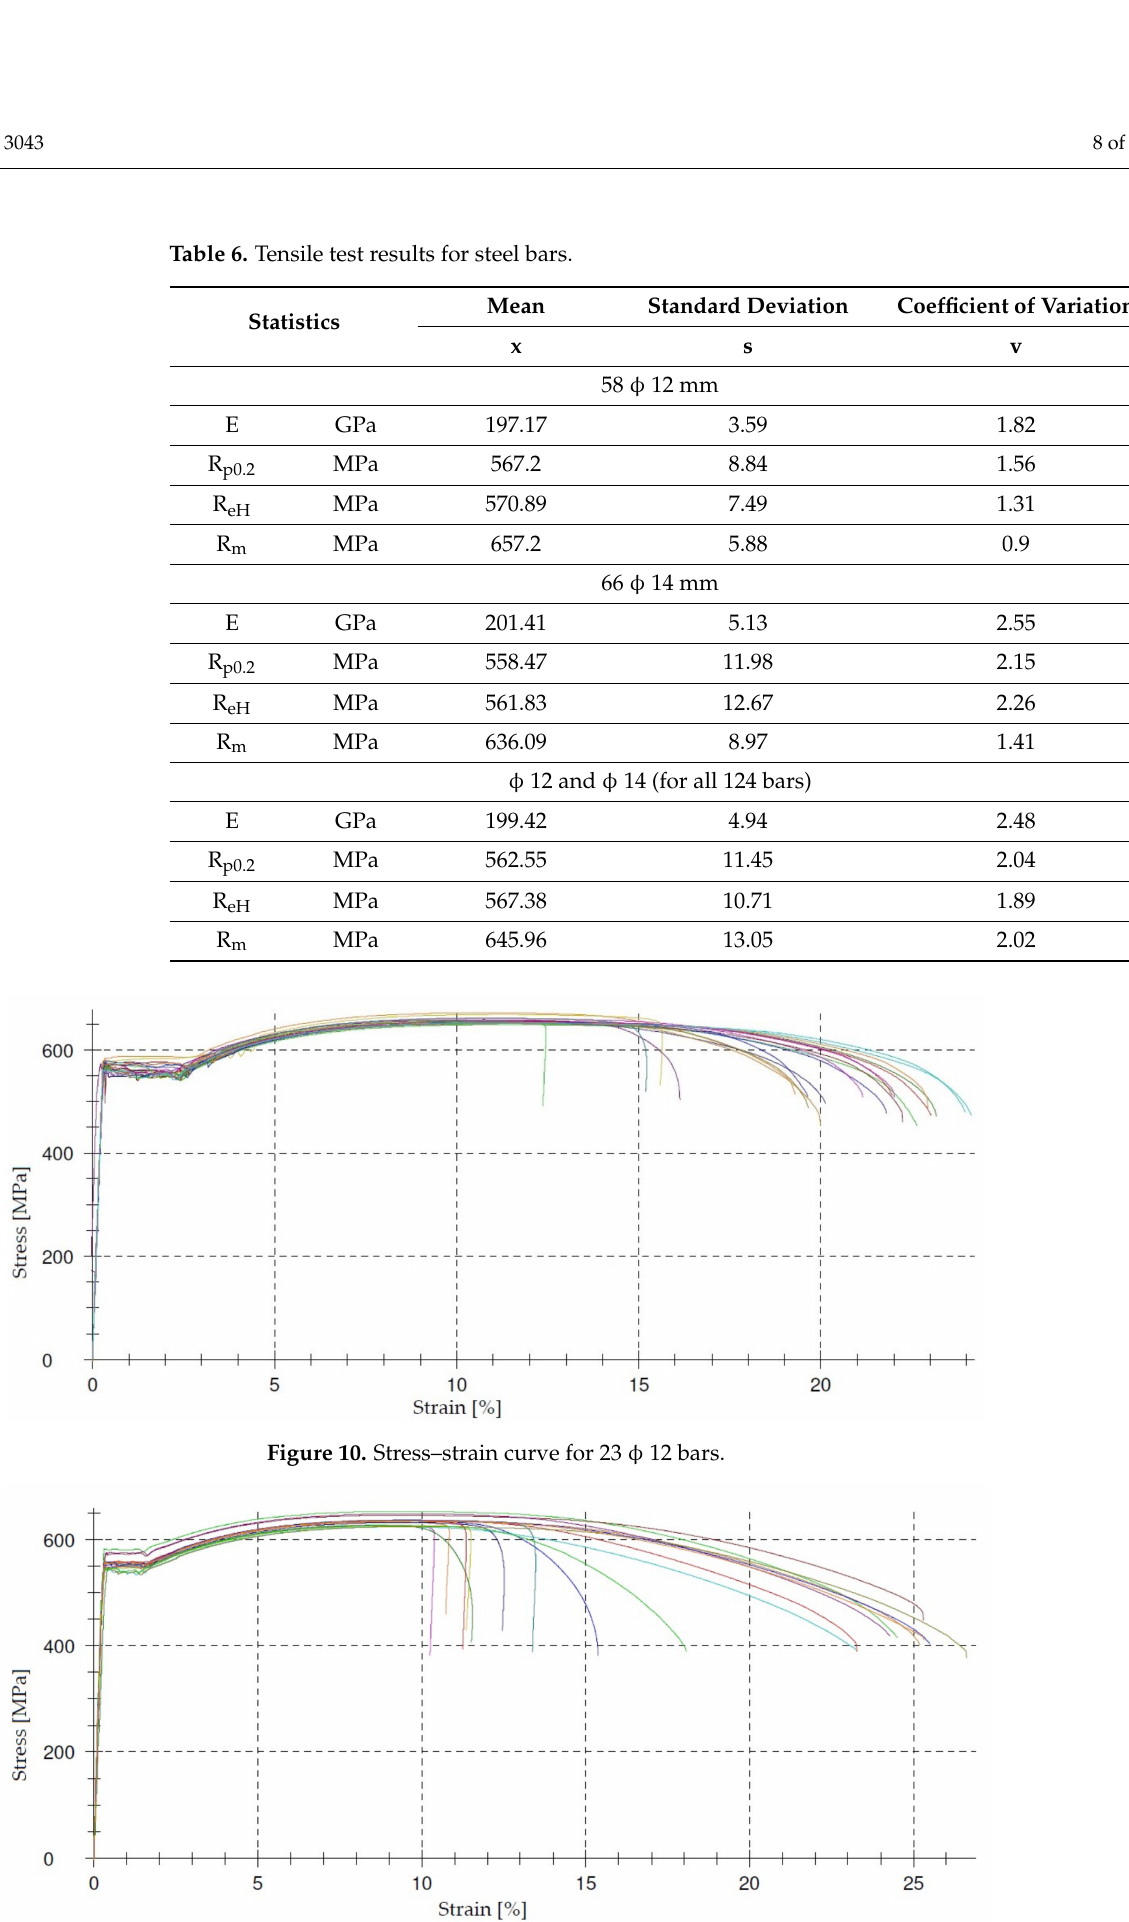
Figure 11. Stress–strain curve for 18 φ 14